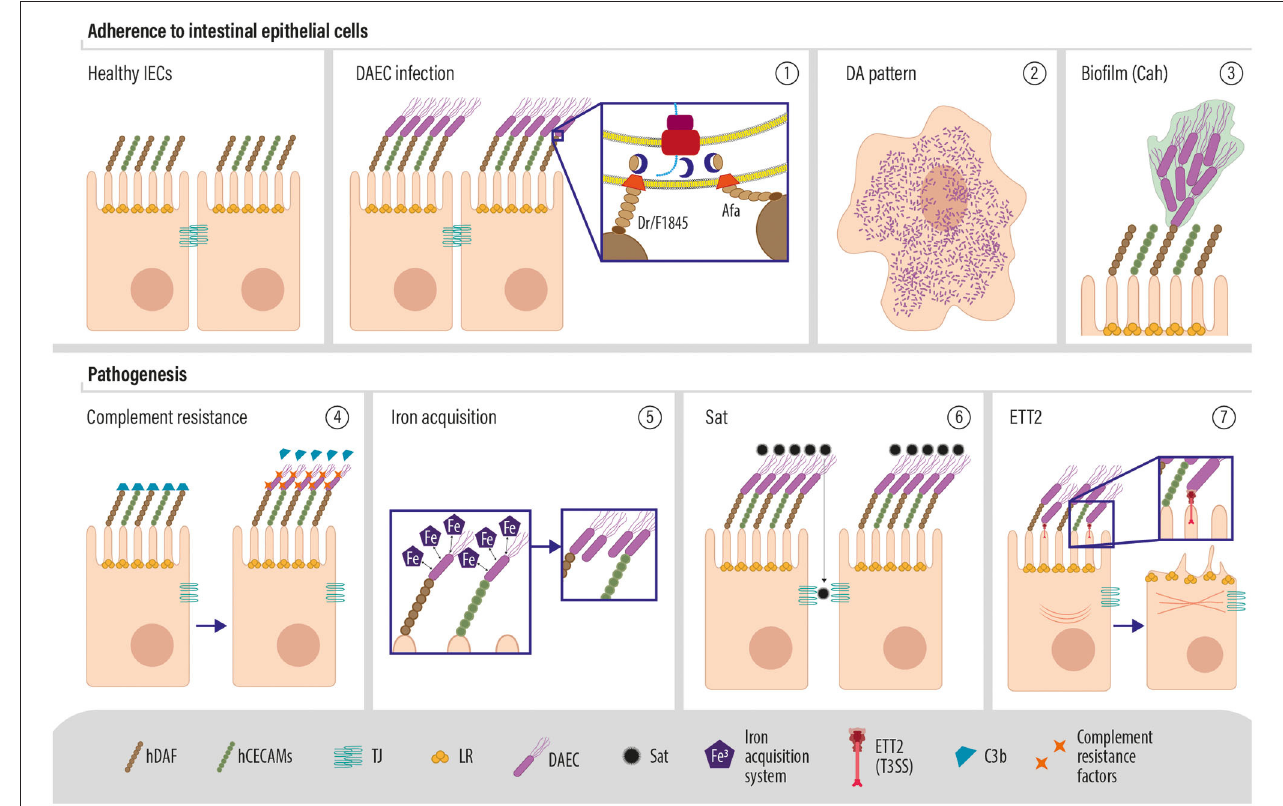
FIGURE 4 | Molecular pathogenesis of DAEC (1). DAEC expresses Afa/F1845/Dr adhesins that interact with the decay accelerating factor (also known as Dr or CD55) and (2) are responsible for the characteristic diffuse adherence (DA) pattern exhibited by this pathotype (3). The production of Cah may assist in the initial adherence to enterocytes or with production of biofilm (3). Adherence of the bacteria may dampen the inhibitory activity of hDAF, which could result in a decreased inactivation of the complement. However, DAEC strains carry a wide variety of complement resistance factors, which might protect the bacteria (4). Iron acquisition systems are common among DAEC, suggesting an important role for iron scavenging in DAEC infection, which may facilitate bacterial replication and colonization (5). The serine protease Sat is also common among DAEC strains and it is associated with the loss of cell shape and potentially detachment from epithelial layers. Finally, the ETT2 type 3 secretion system may deliver intracellular effectors to the enterocytes, which may induce cytoskeletal modifications.